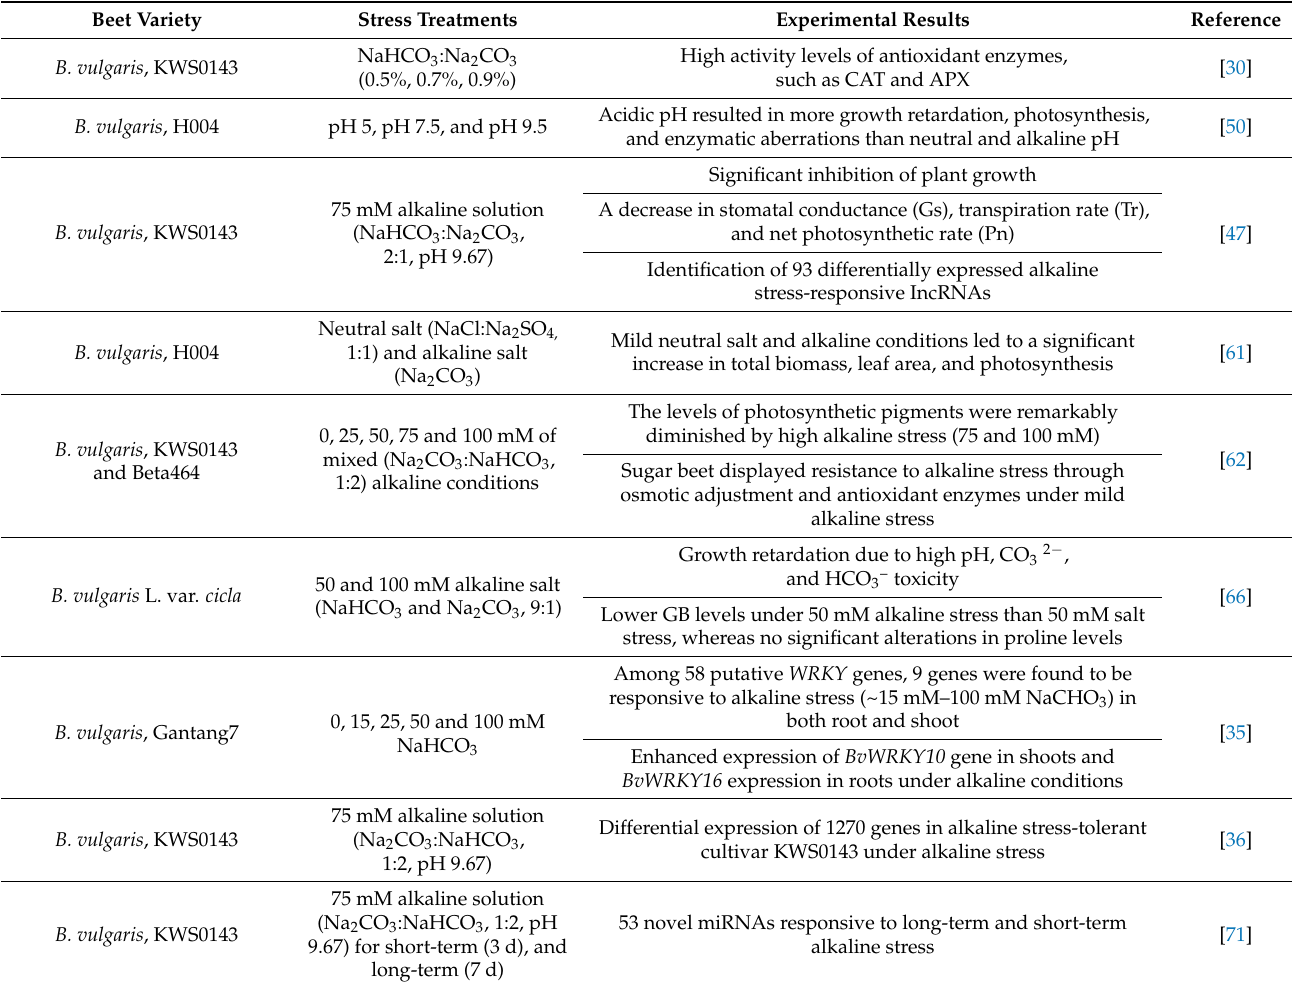
Table 2. Alkaline stress responses in cultivated